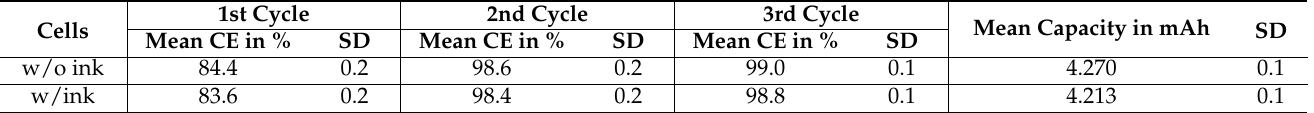
Table 1. Mean Coulomb efficiency and standard deviation (SD) during the first three forming cycles and the mean capacity and SD obtained for each coin cell with and without